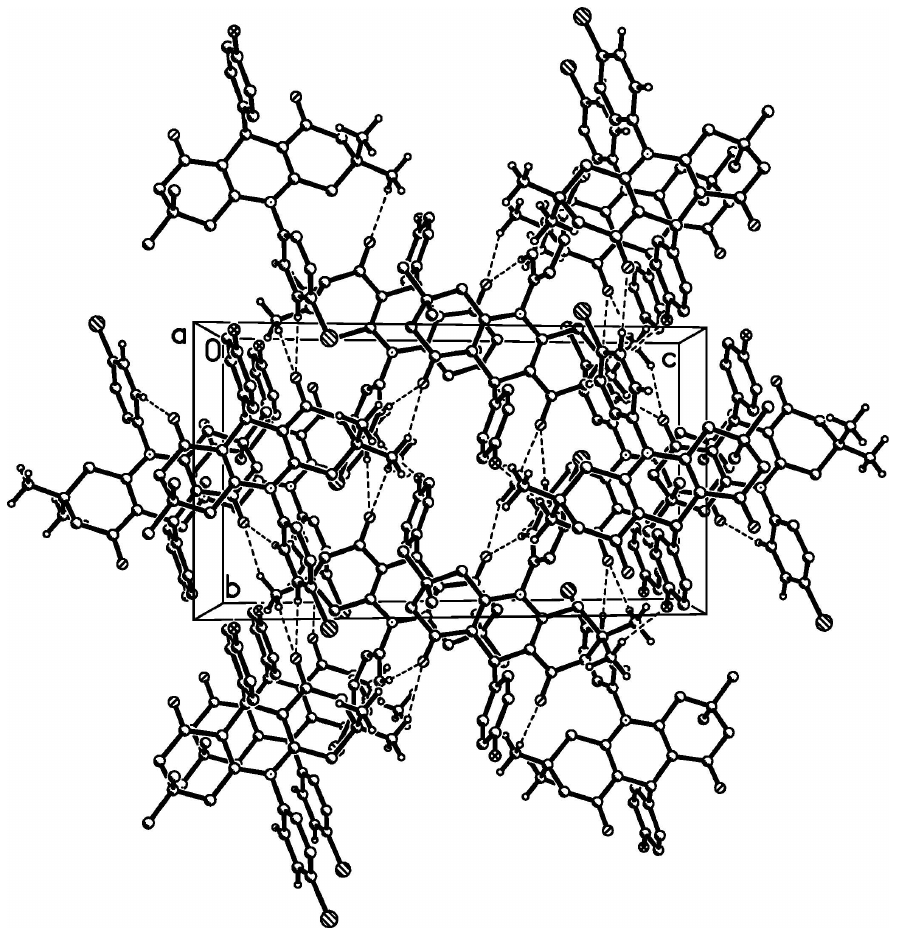
Figure 2 The molecular packing including the hydrogen-bonding network. 10-(4-Chlorophenyl)-9-(4-fluorophenyl)-3,3,6,6-tetramethyl-3,4,6,7,9,10- hexahydroacridine-1,8(2 H ,5 H